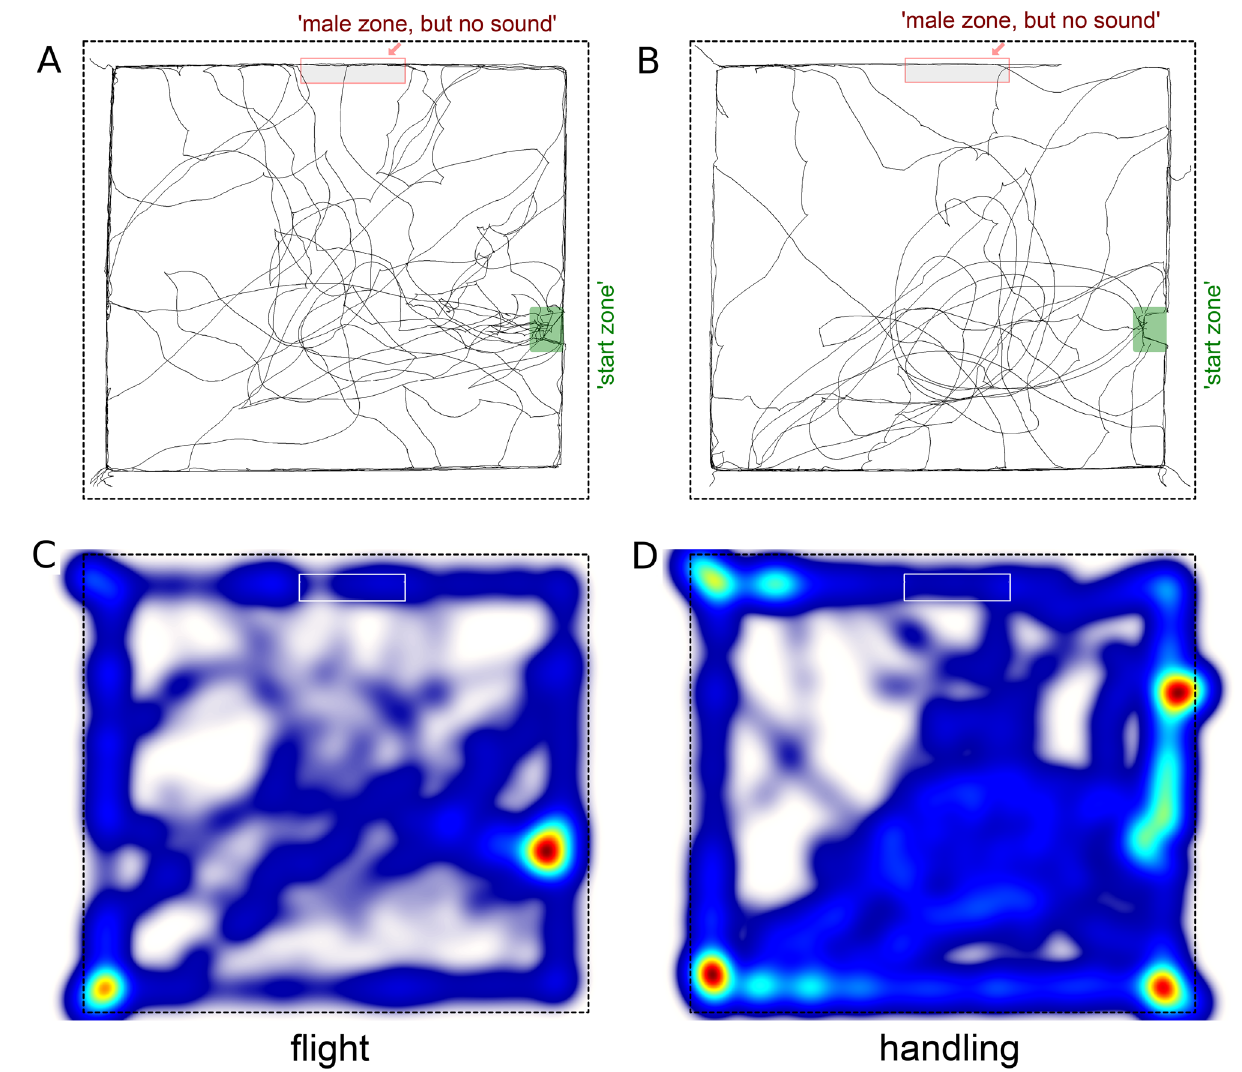
Figure 6. Visualized tracks of female crickets in the arena with the loudspeaker turned off. A and B show the overlay of all individual tracks for ’flight’ (A) and ’handled’ groups (B) , respectively. Heatmaps (C,D) show the data normalized proportionally to the time spent by crickets in each site of the arena, from blue to red. All symbols and notations as in the Figs. 1 and